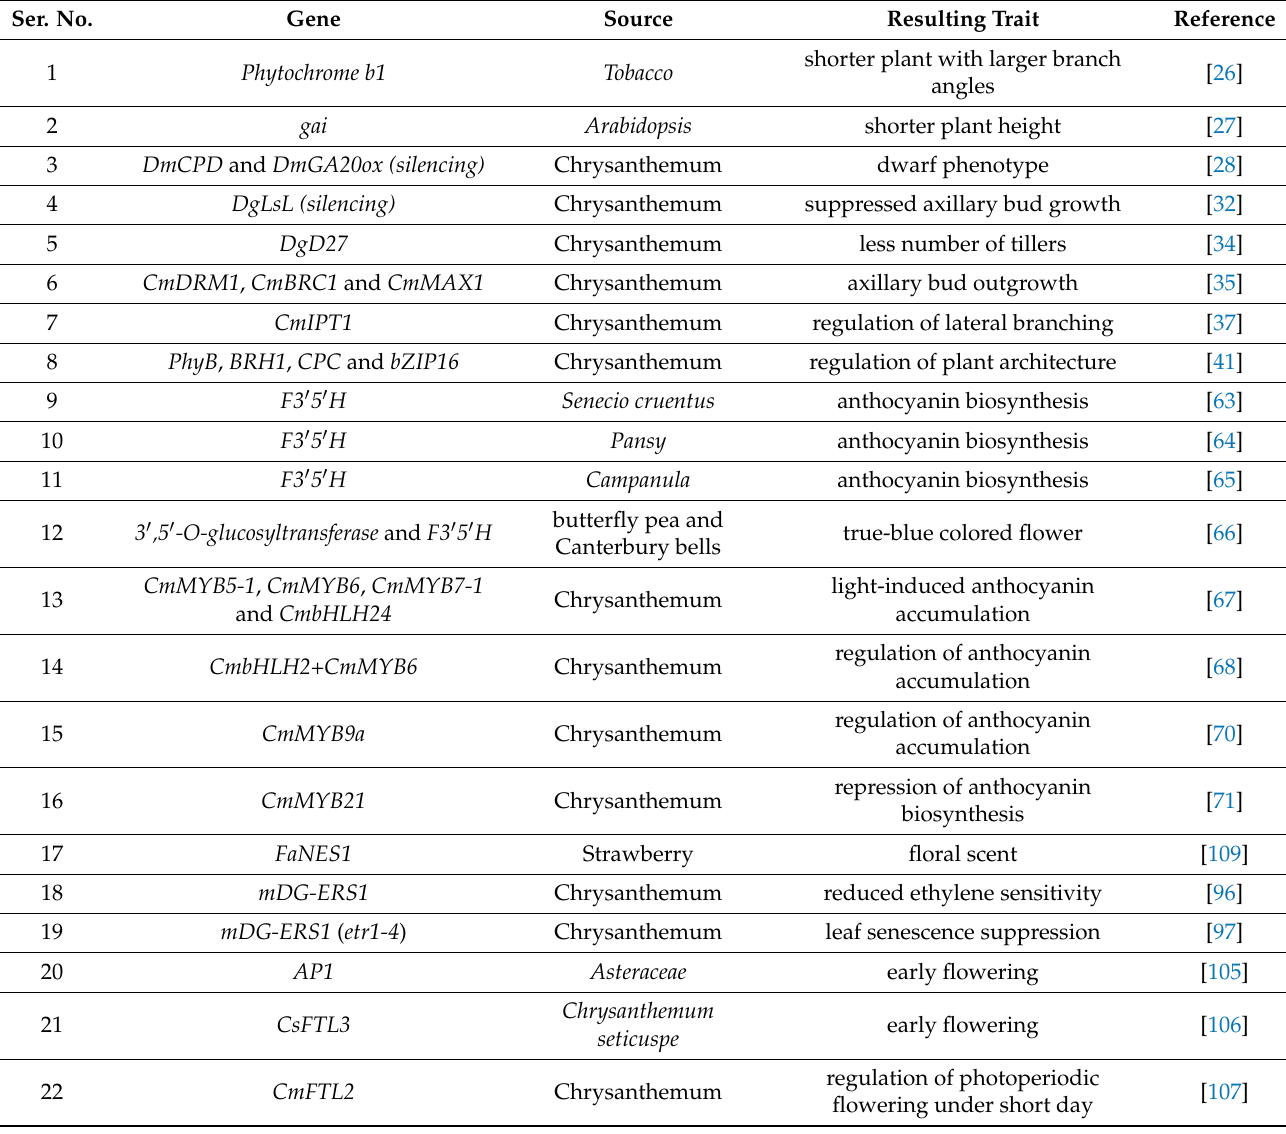
Table 1. Role of various genes involved in the improvement of ornamental traits in chrysanthemum. Ser. No. Gene Source Resulting Trait